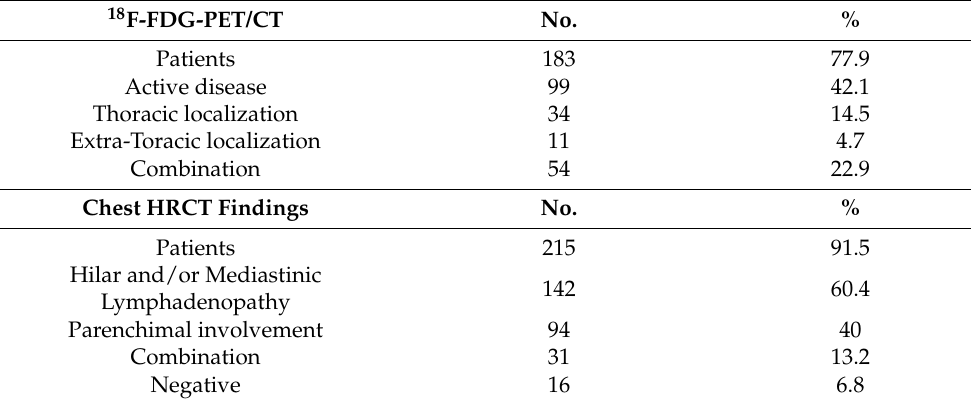
Table 6. Radiodiagnostic and nuclear medicine imaging.